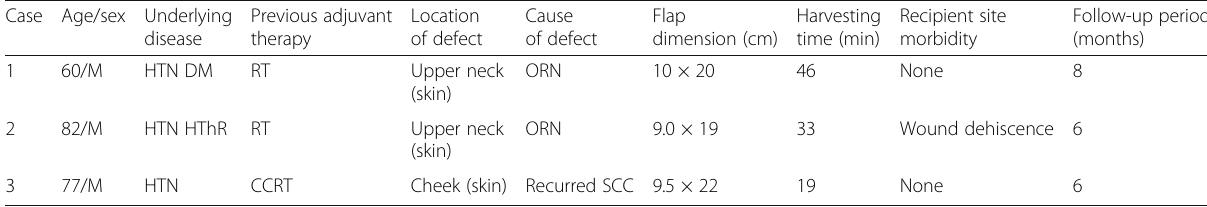
Table 1 The characteristics of patients who underwent supraclavicular artery island flap reconstruction Case Age/sex Underlying disease